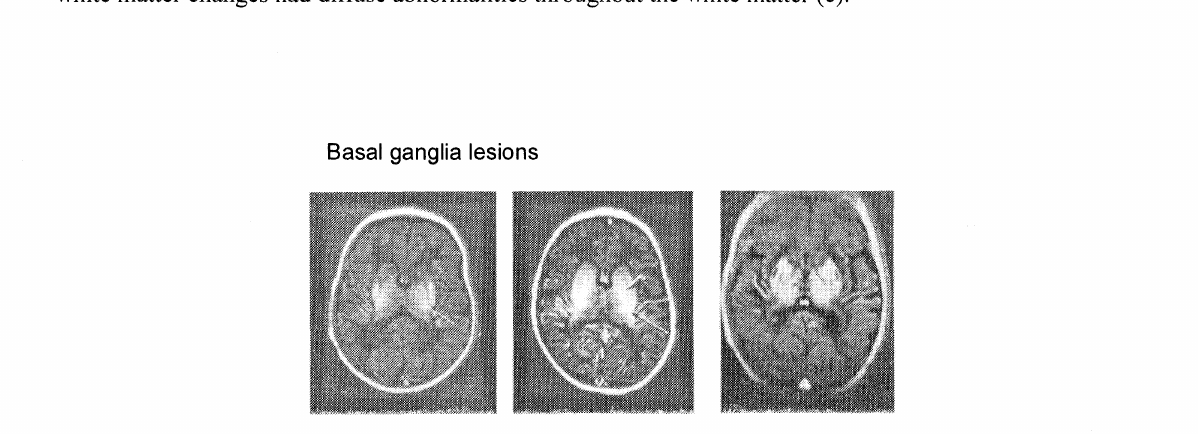
Fig.2: Axial IR image at basal ganglia lesions. Note the discrete changes in the lentiform in (a) and the more marked lesions in lentiform and thalamus in (b). Basal ganglia and thalami have marked and diffuse abnormalities in